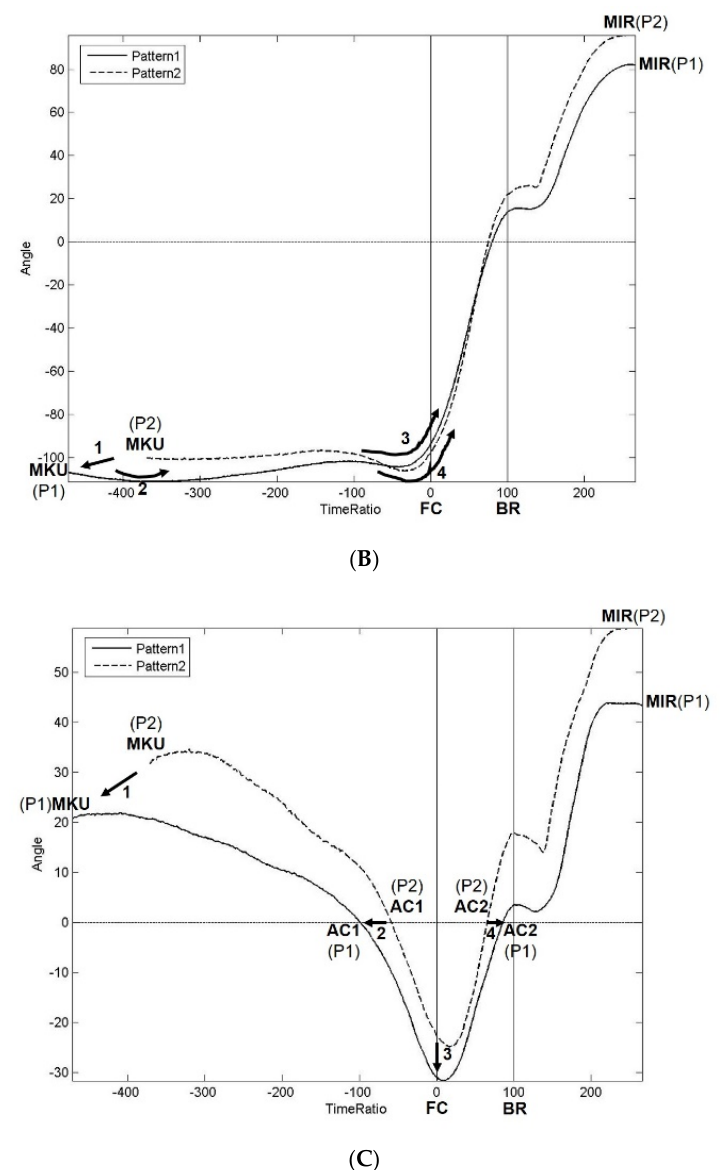
Figure 4. ( A ) Curves of mean pelvic angle of Pattern1 and Pattern2 related to time ratio from MKU to MIR. Arrow1 indicates that Pattern1 has an earlier MKU than Pattern2. Arrow2 indicates that Pattern1 has more of a leading pelvic rotational angle at the moment of foot contact (“PAoFC”) than Pattern2. ( B ) Curves of mean trunk angle of Pattern1 and Pattern2 related to time ratio from MKU to MIR. Arrow1 indicates that Pattern1 has an earlier MKU than Pattern2. Pattern1 entails the backward rotation of the trunk in Phase1 (Arrow2), whereas Pattern2 does not feature this behavior. Pattern2 shows a turning-back of the trunk prior to foot contact in Phase2 (Arrow4), whereas Pattern1 does not present this tendency (Arrow3). ( C ) Curves of mean trunk–pelvis separation (TPS) of Pattern1 and Pattern2 related to time ratio from MKU to MIR. Arrow1 indicates that Pattern1 has an earlier MKU and less of a TPS in Phase1 due to the backward rotation of the trunk. Pattern1 has an earlier AC1 (Arrow2) and later AC2 (Arrow4) than Pattern2. Pattern1 exhibits more of an absolute value of negative TPS at the moment of foot contact (“TPSoFC”) than Pattern2 (Arrow3). Note that Pattern1 and Pattern2 have different mean time ratios of MKU, MIR, AC1 and AC2 in ( A – C ). AC1 = time of first pelvic and trunk angle crossing; AC2 = time of second pelvic and trunk angle crossing; BR = ball-release; FC = foot contact; MIR = maximum-shoulder-internal-rotation; MKU = maximum-knee-up; P1 in parentheses = Pattern1; P2 in parentheses =